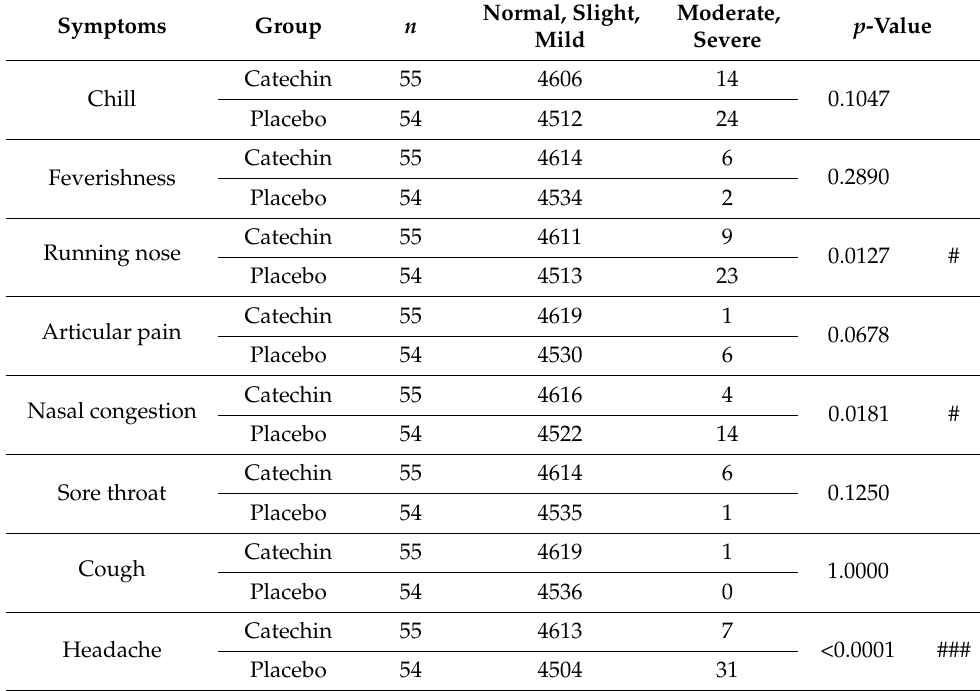
Table 4. Cumulative duration (in days) of grades as scores of severe–moderate and mild–normal for each